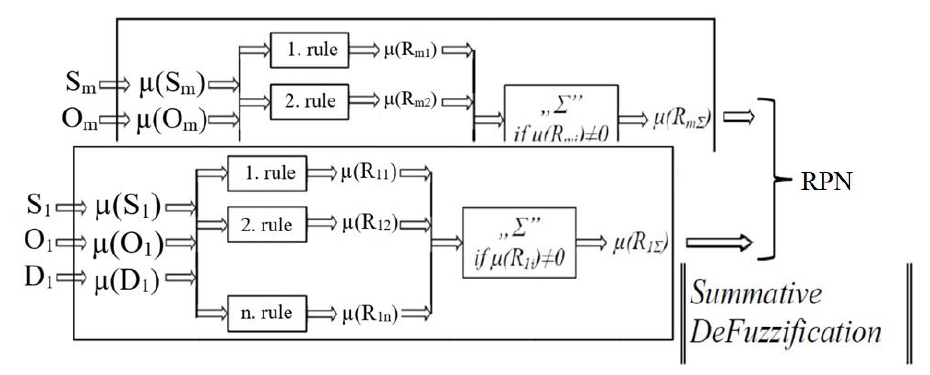
Figure 5. Flow chart of summative defuzzification process.